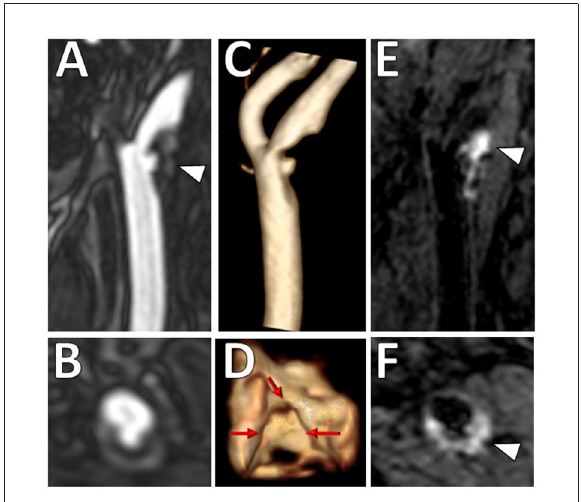
FIGURE3 Ulcerated plaque with intraplaque hemorrhage on VW-MRI. Male patient presented with clinical and imaging evidence of a 1–2-year history of recurrent left MCA territory infarcts. (A,B) Contrast-enhanced MRA neck confirmed a left cervical carotid bifurcation stenosis with an ulcerated plaque ( A , arrowhead). (C,D) 3D surface volume rendering of the left carotid plaque depicts the ulcerated surface morphology with (D) axial image through the ulceration showing marked surface irregularity (red arrows). (E,F) Carotid VW-MRI showed intraplaque hemorrhage (arrowheads), depicted as T1 hyperintense signal on a fat-suppressed T1W MPRAGE image. Based on the clinical and imaging findings, the patient underwent a left carotid